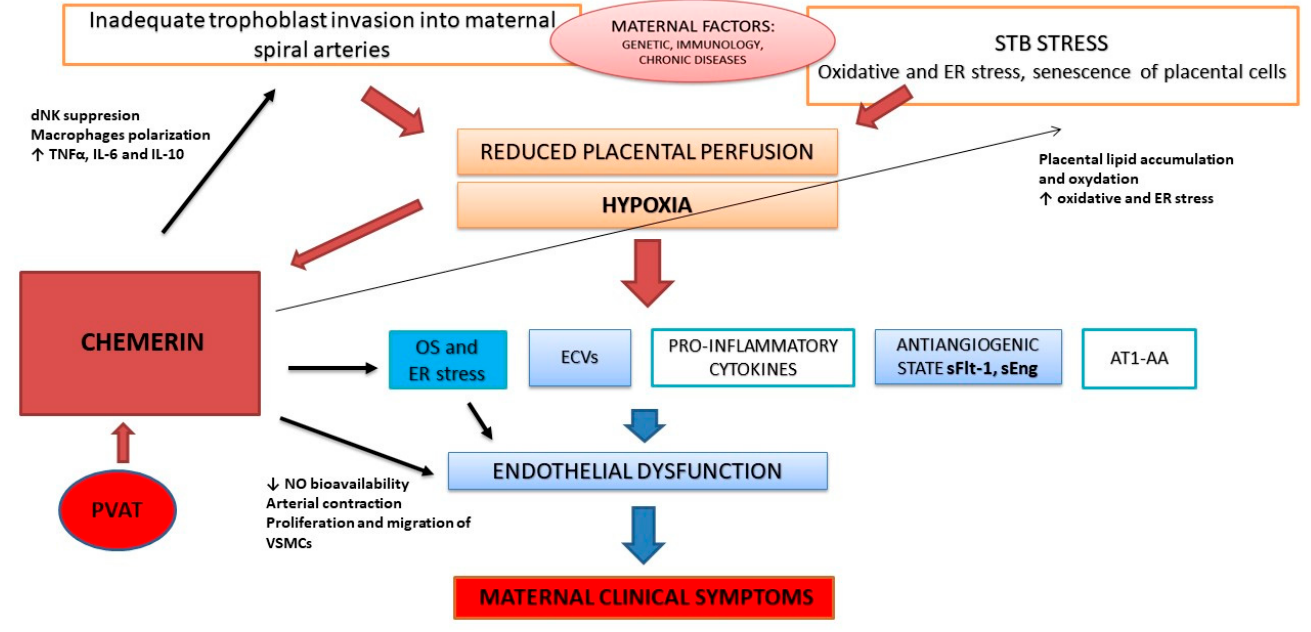
Figure 1. The potential role of chemerin in the pathophysiology of PE. PVAT—perivascular adipose tissue; STB—syncytiotrophoblast; OS—oxidative stress; ER—endoplasmic reticulum; ECVs—extracellular vesicles; sFlt-1—soluble fms-like tyrosine kinase 1; sEng—soluble endoglin; AT1-AA angiotensin II 1 receptor autoantibodies; TNF α — tumor necrosis factor α ; VSMCs—vascular smooth muscle